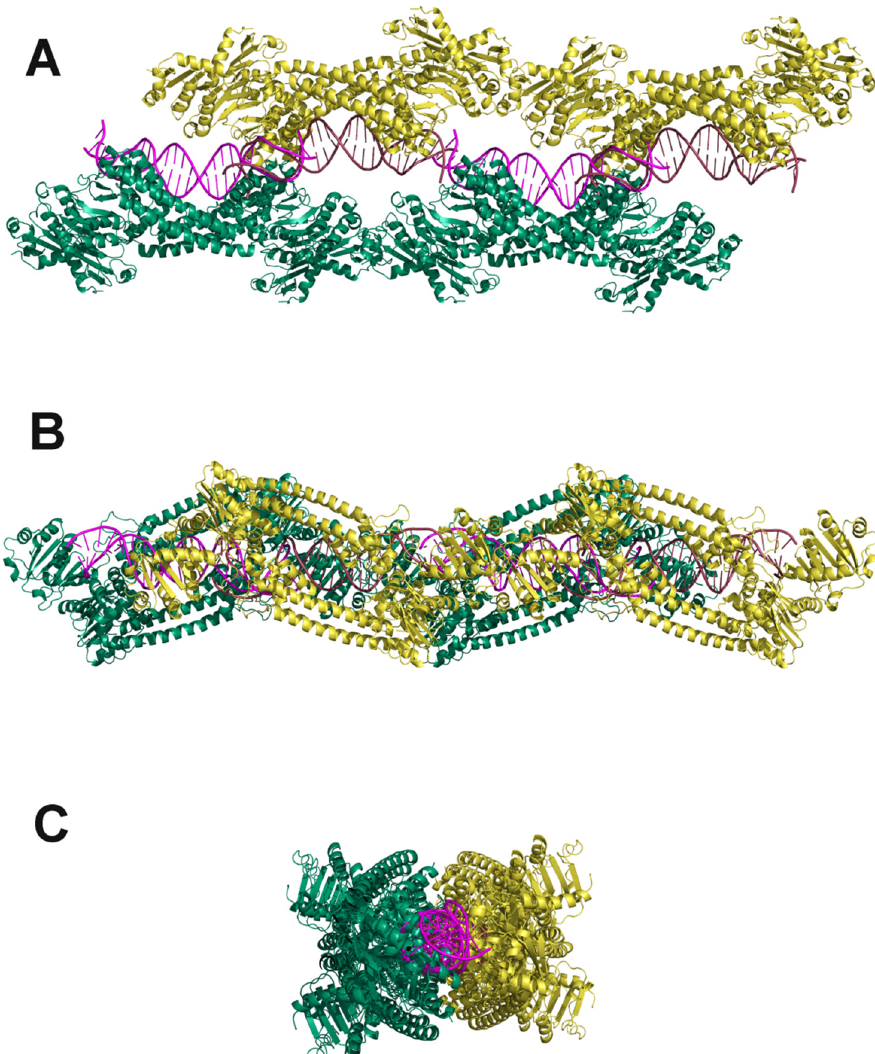
Fig 7. A model for the TrmBL2 filament using the crystal structure of TrmBL2 with bound dsDNA. In the crystal structure of TrmBL2 from Pyrococcus furiosus [10] four protein molecules bind to the 19 basepairs long TGM dsDNA. In the filament model shown in panel A, it comprises the first quarter with DNA (pink) and the protein tetramer (green). First an octameric complex was constructed from two copies of the crystal structure. In the uppermost panel it comprises the left halve with one pink, one red DNA piece, one green and one yellow tetramer. Two copies of the octameric complex were shifted in tandem to get a continuous dsDNA running through both as seen in panel A. The resulting dsDNA in the hexadecamer has zero overall curvature. The hexadecameric filament model is shown in ribbon representation in three orthogonal views (A-C). Note the almost full coverage of the DNA by TrmBL2 and that the DNA is in an almost perfectly linear